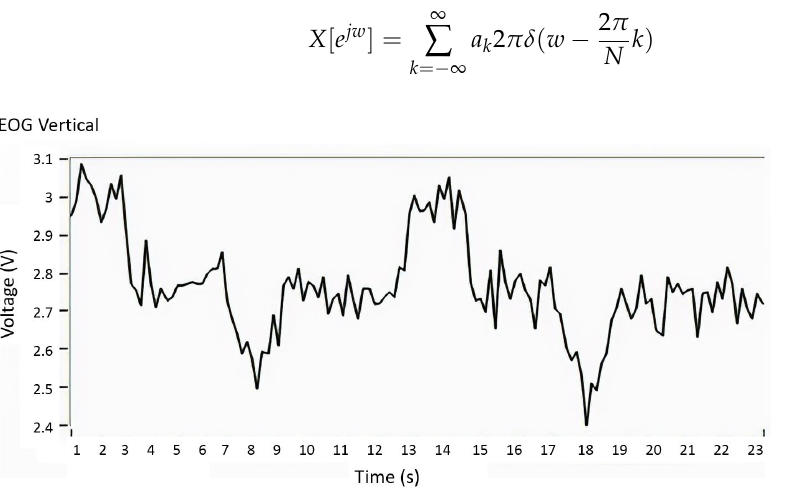
Figure 11. EOG signal with induced noise. Acquisition of EOG signal with induced noise as interference of unknown